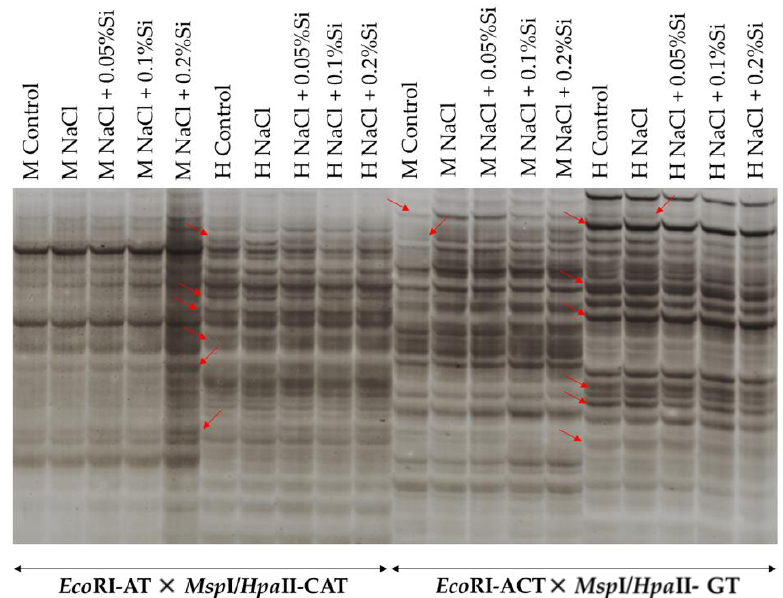
Figure 6. Example image of selective amplification products of Eco RI-AT × Msp I/ Hpa II-CAT and Eco RI-ACT × Msp I/ Hpa II- GT selective starters; Red arrows indicate polymorphic bands. The methylation frequency (symmetric, hemi-, and total methylation) was